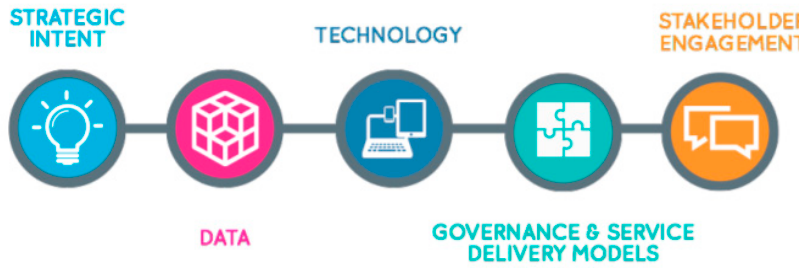
Figure 3. Smart Cities Maturity Model. Source: [106].